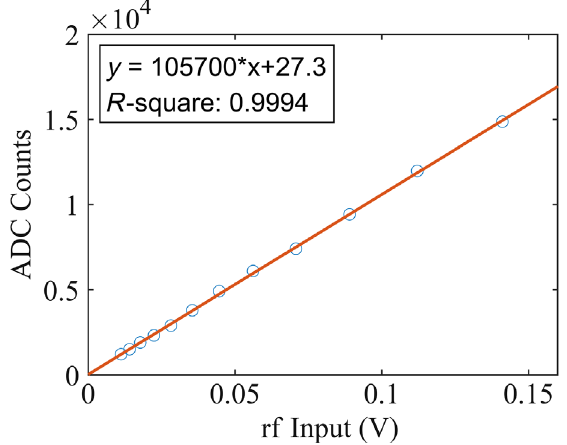
FIG. 8. Amplitude linearity test results of the